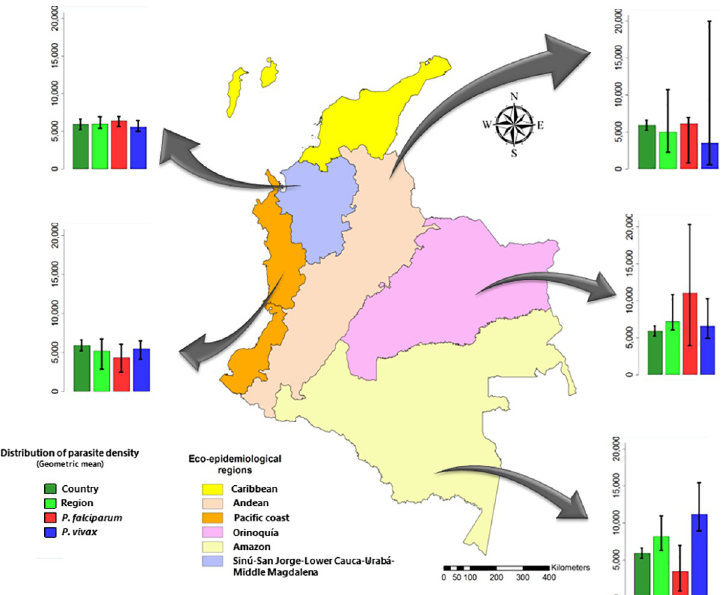
Fig 1. Distribution of parasite density levels in severe malaria by ecoepidemiological region and parasitic species in Colombia, 2014–2017.